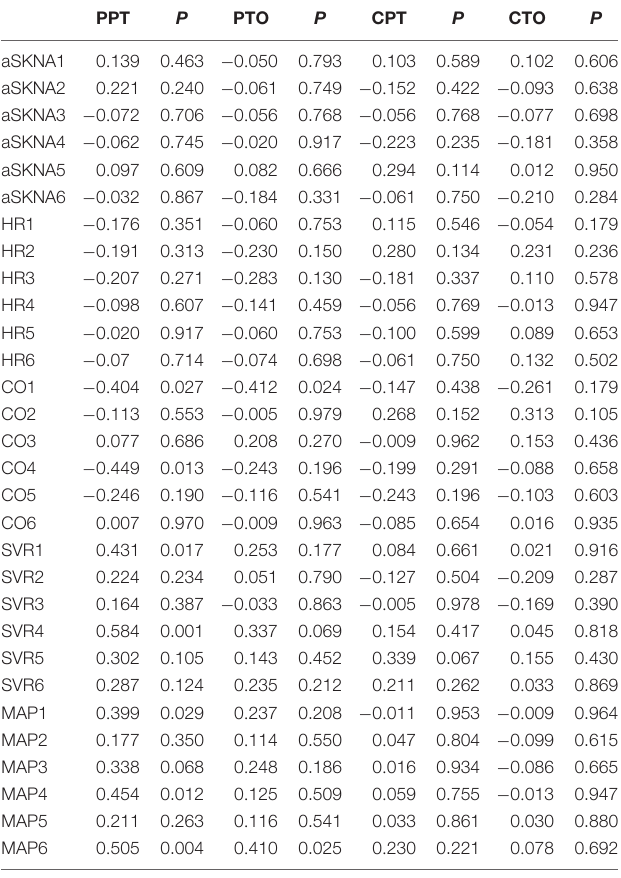
TABLE 2 | Correlation between basal pain sensitivity and skin sympathetic nerve activity and cardiovascular